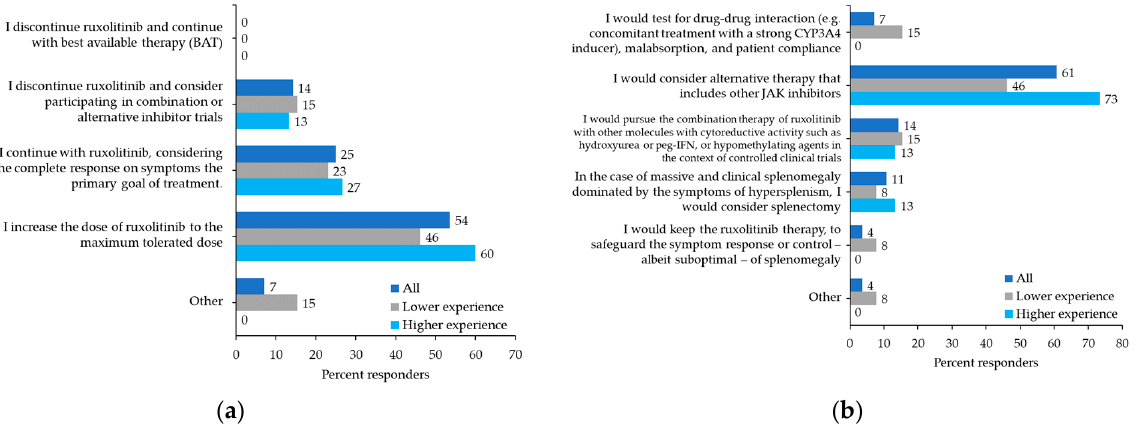
Figure 3. Participant preferences: ( a ) Leukocytosis/response on symptoms only: full control of systemic symptoms may be achieved in the patient receiving ruxolitinib, even in the presence of uncontrolled myeloproliferation (persistence of splenomegaly, hyperleukocytosis). If so, which therapeutic approach would you consider? ( b ) Splenomegaly due to failure to respond to adequate or maximum tolerated dose (resistance): how do you manage the problem of primary resistance splenomegaly or loss of response to ruxolitinib?